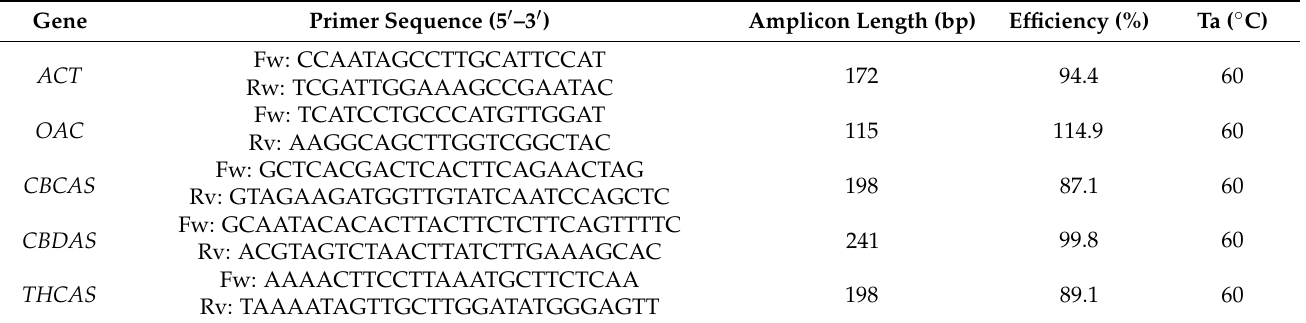
Table 5. List of primers for all studied genes. Forward (Fw) and reverse (Rv) primer sequences, amplicon length expressed in base pairs (bp), PCR efficiency (Eff), and annealing temperature